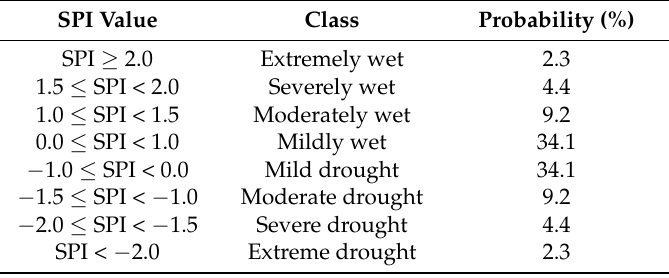
Table 2. Climate classification according to the Standardized Precipitation Index (SPI) values